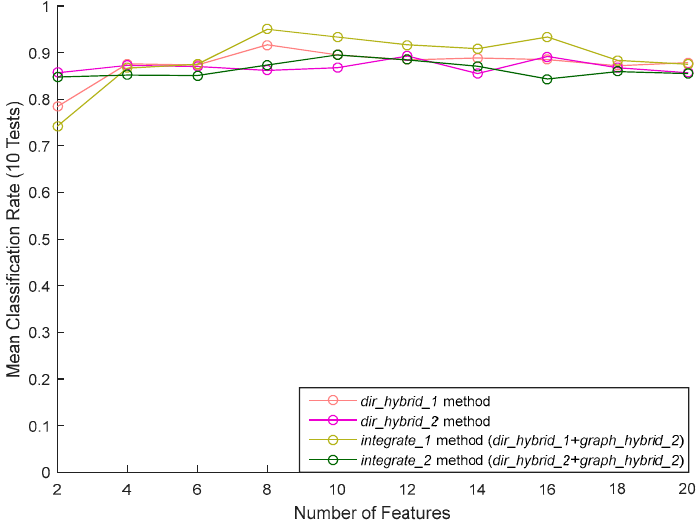
Figure 20. The integration of the direct and graphical methods.